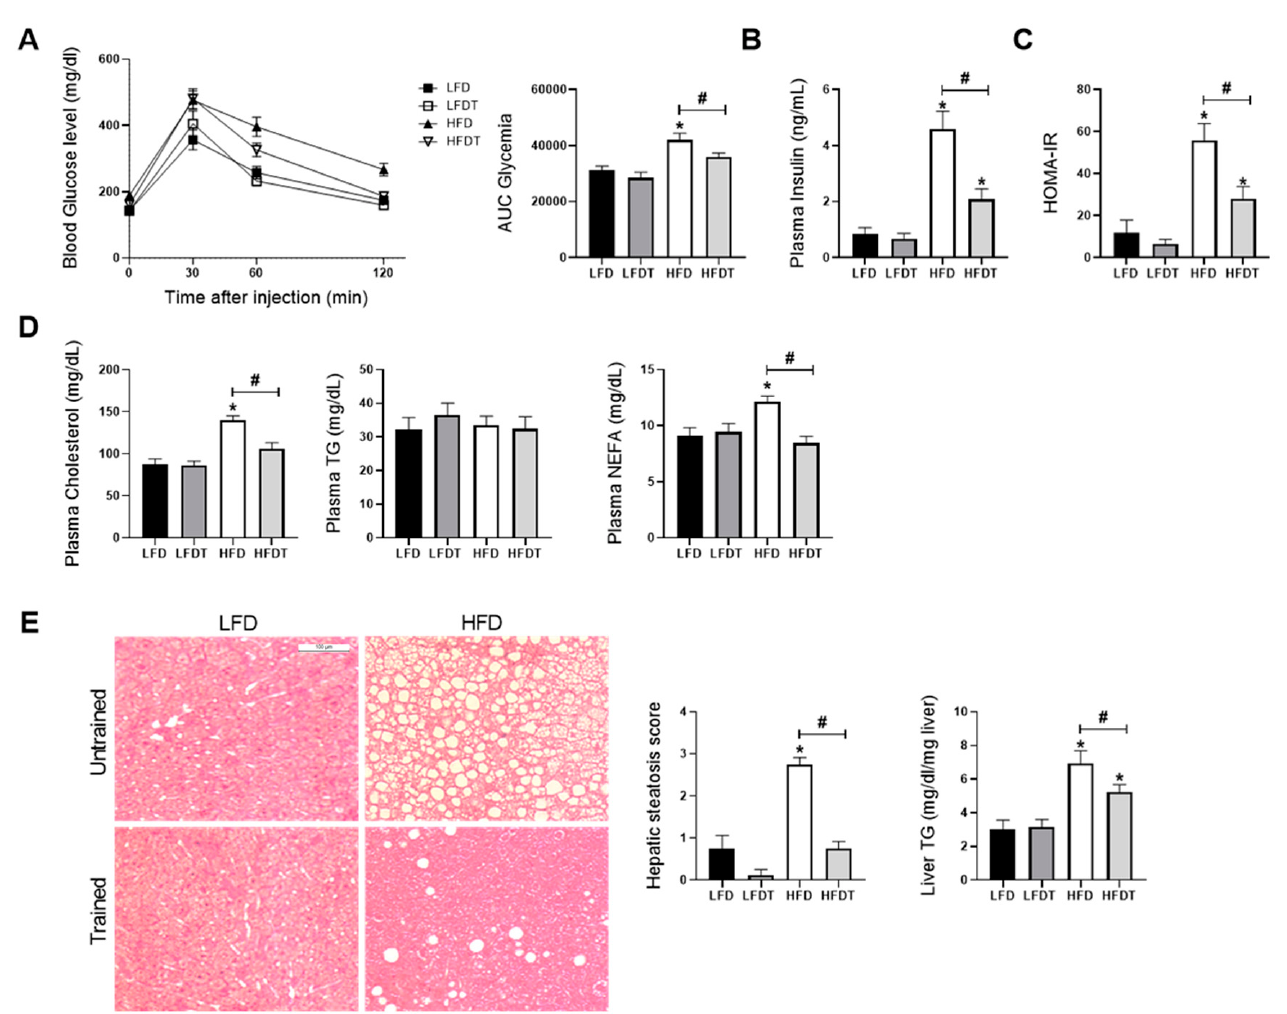
Figure 2. Delayed EET improves obesity-induced metabolic disorders and hepatic steatosis in HFD mice. ( A ) Glucose tolerance test at week 20. Fasted mice were submitted to an intraperitoneal injection of glucose (2 g/kg b.w.). Glycemia was measured before (0) and 30, 60 and 120 min after injection. Histogram represents the area under the curve (AUC) of glycemia from 0 to 120 min. ( B ) Plasma insulin level at week 20. ( C ) HOMA-IR index calculation. ( D ) Plasma levels of cholesterol, triglycerides (TG) and nonesterified fatty acids (NEFA) at week 20. ( E ) Representative photomicrograph (original magnification × 400; scale bar: 100 µ m) of H&E staining illustrating hepatic steatosis from liver sections from mice on LFD, LFDT, HFD and HFDT at week 20 of the experimental protocol, steatosis scoring by semiquantitative analyses of lipid accumulation and quantitative analysis of triglycerides (TG) in the liver tissue. Statistical analyses were performed by one-way ANOVA followed by Newman-Keuls post hoc test. Data are presented as means ± SEM. * p ≤ 0.05 versus LFD # p ≤ 0.05 versus HFD. n = 10 in each group.